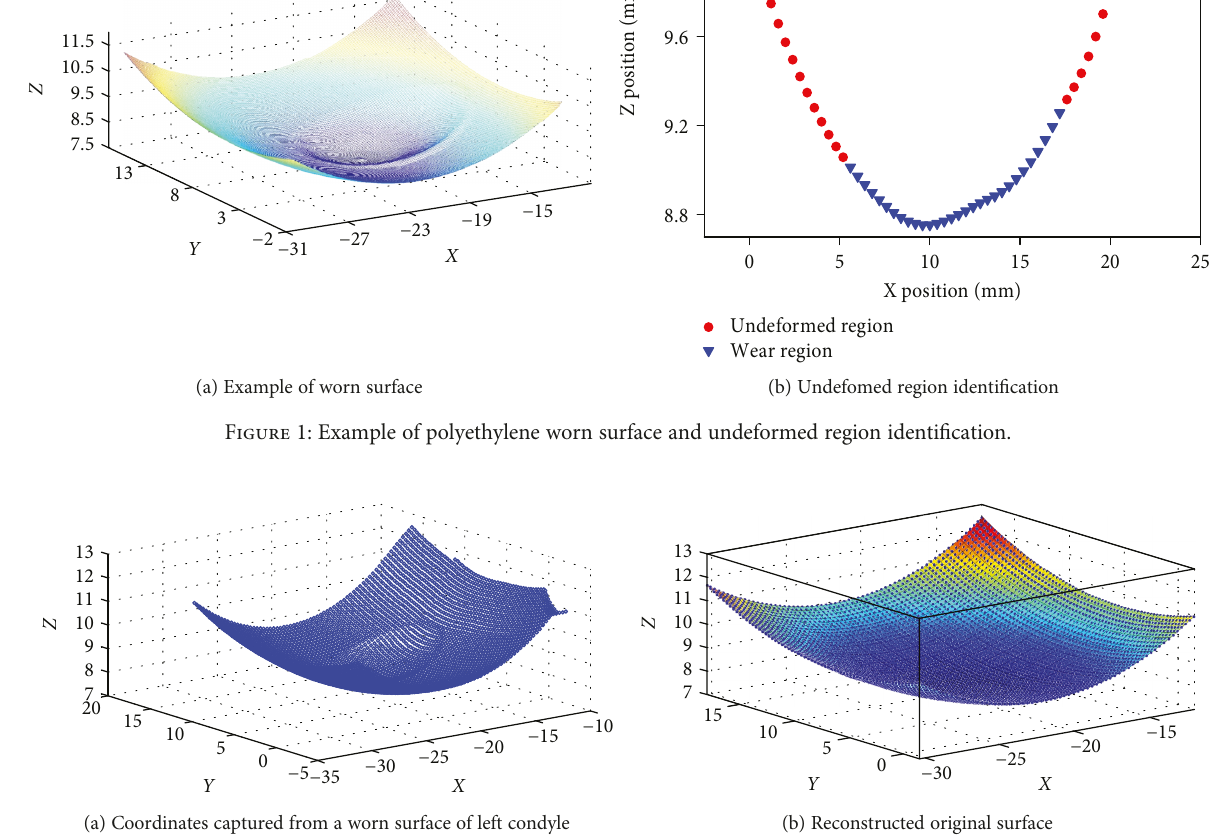
Figure 2: Surface coordinates obtained using CMM and reconstructed original surface for volumetric